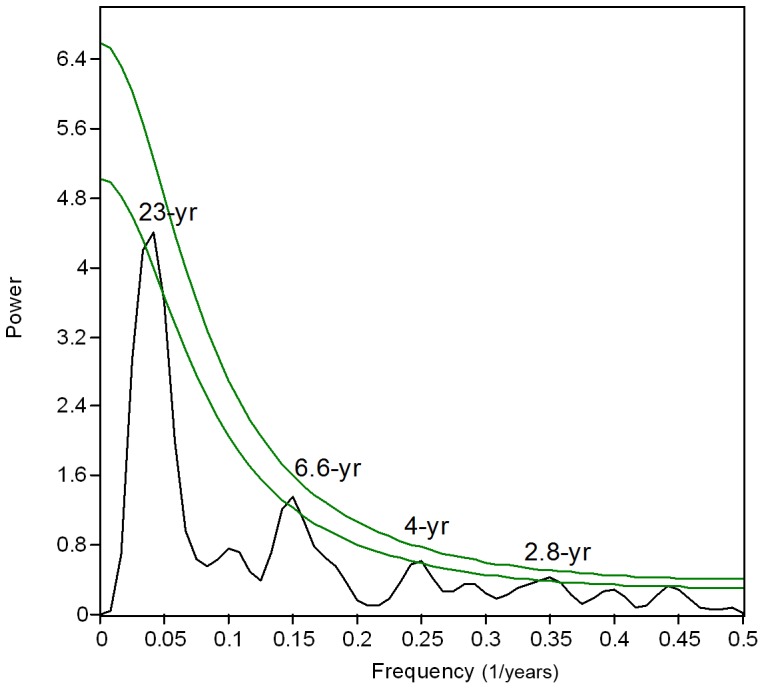
Spectral analysis (REDFIT) of annual G/B anomalies.Significant spectral peaks are indicated. Green solid lines show false-alarm levels of 95% and 99%.